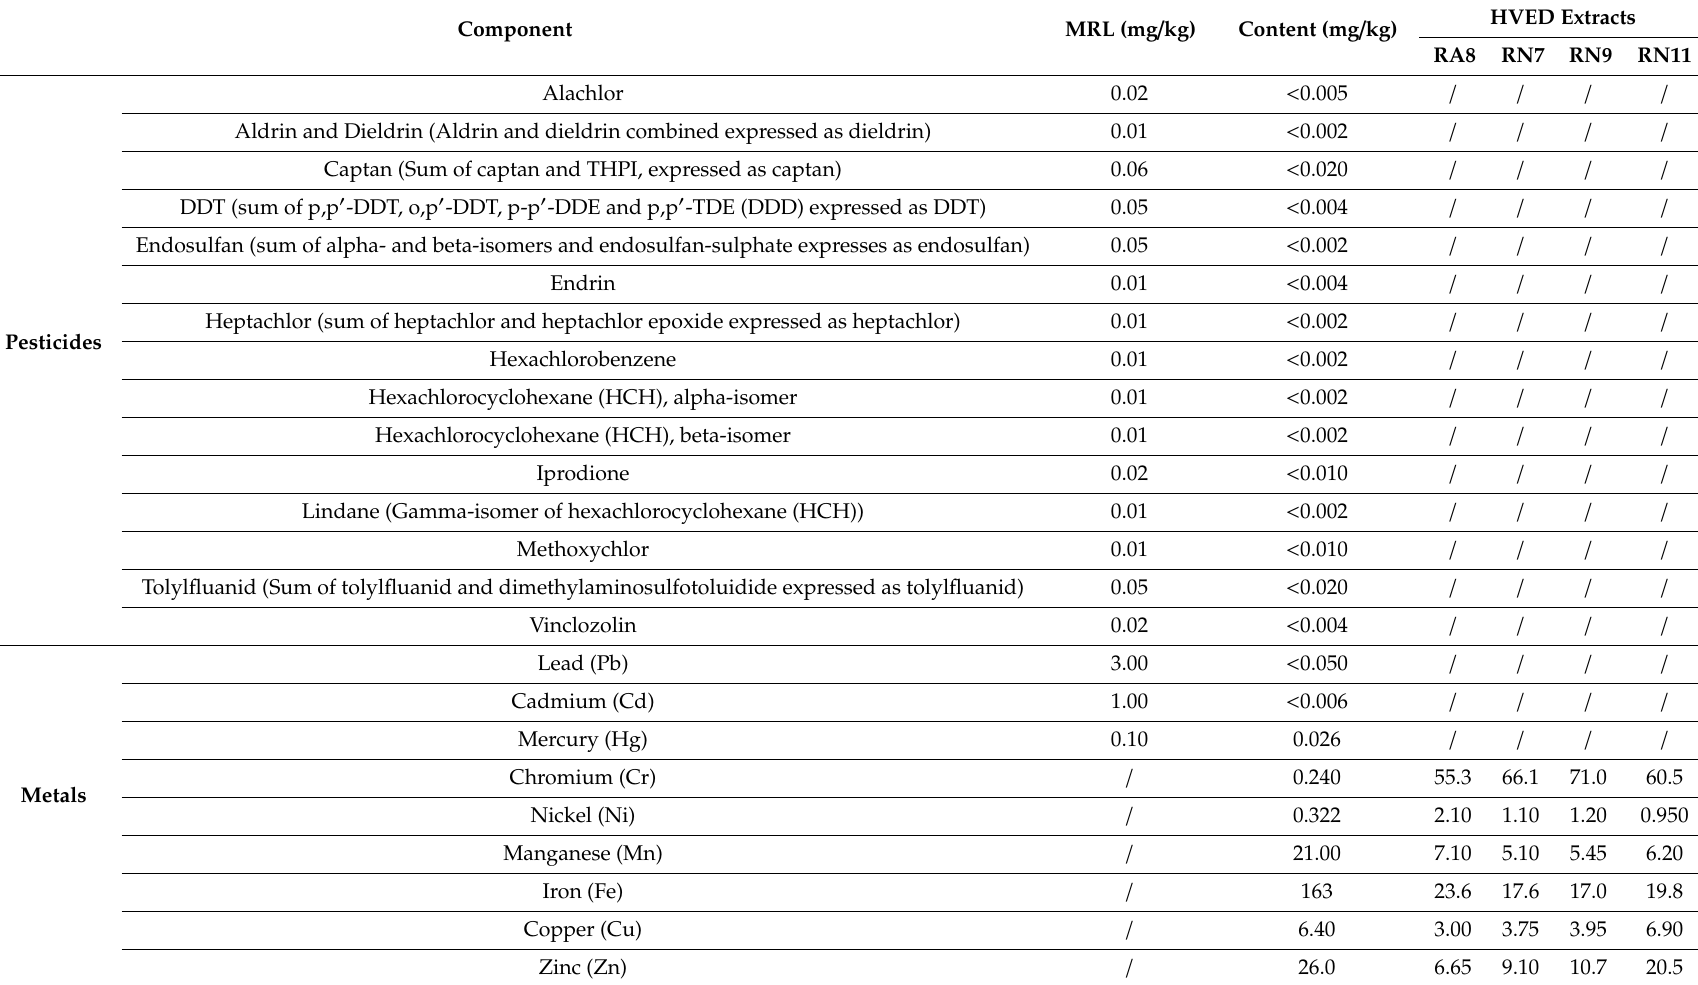
Table 7. Residue levels and maximum residue levels (MRL) of pesticides (mg / kg) and metals (mg / kg) in rosemary